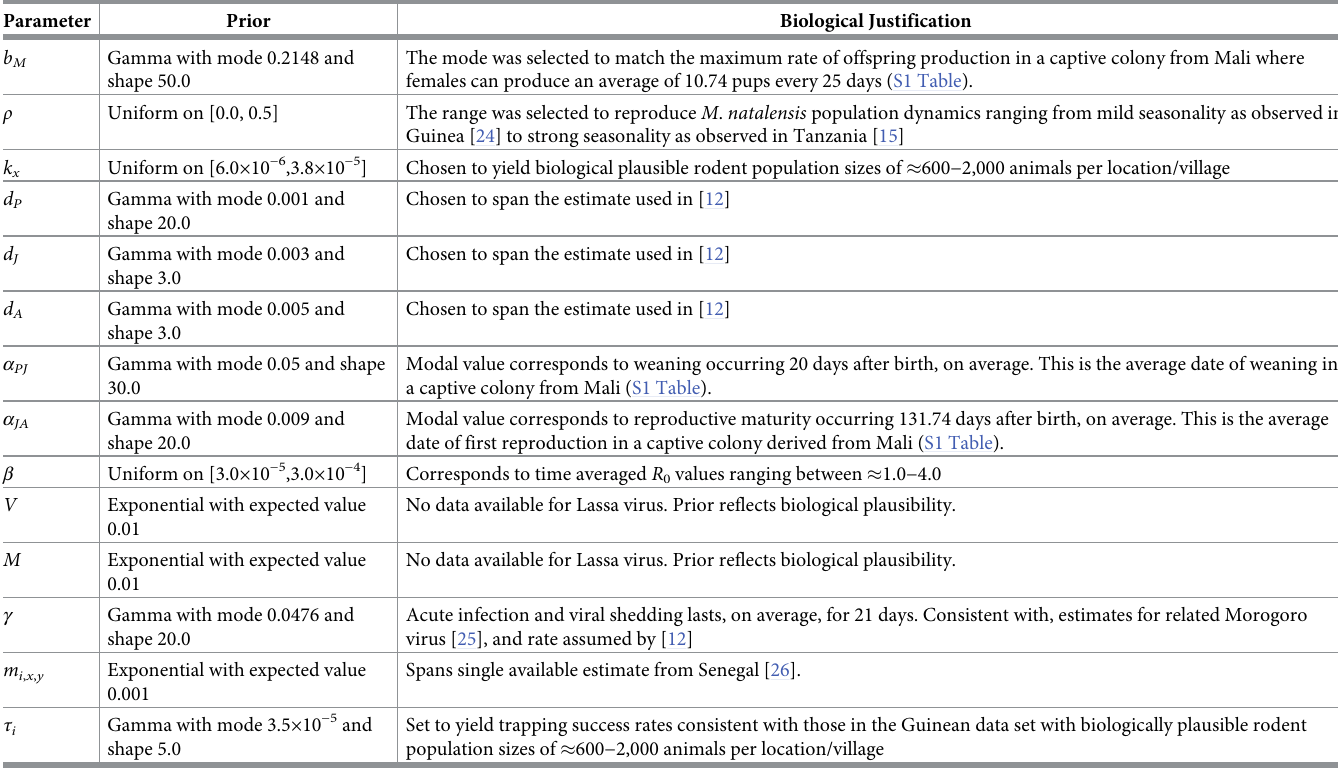
Table 2. Prior distributions for model